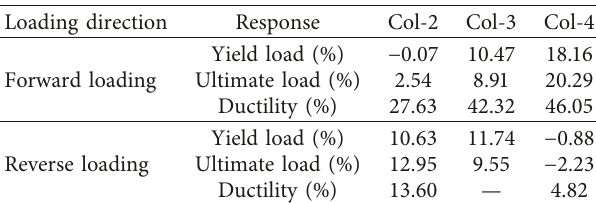
Table 4: Performance degradation of column specimens in comparison with